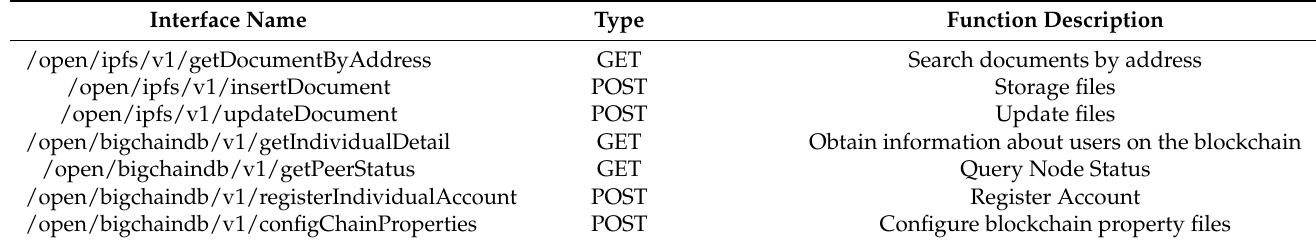
Table 2. Core API List.